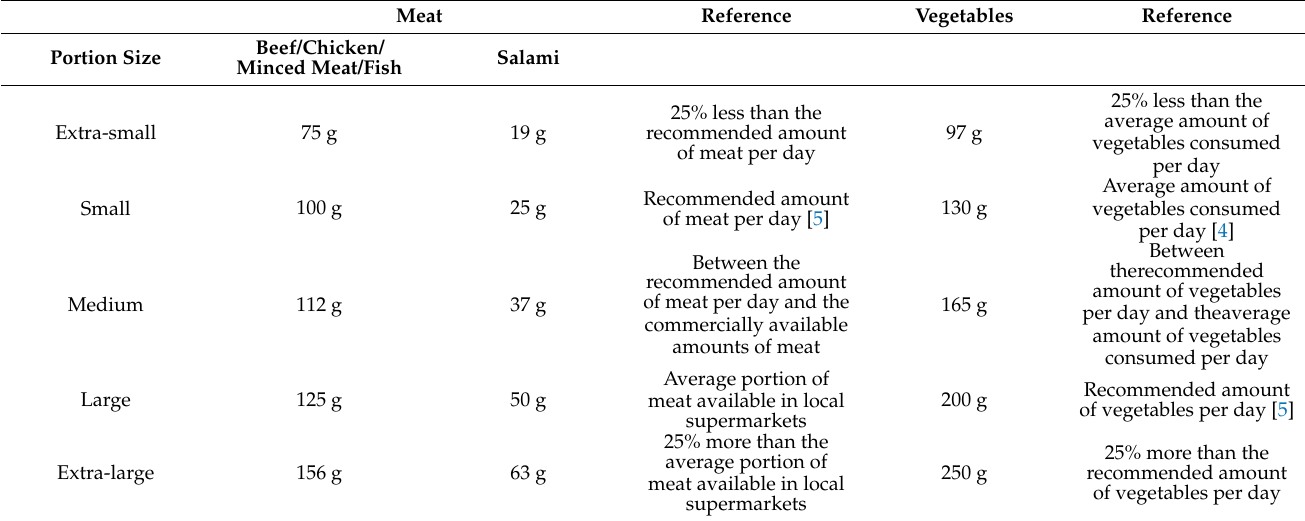
Table 1. Grams of meat and vegetables used per portion